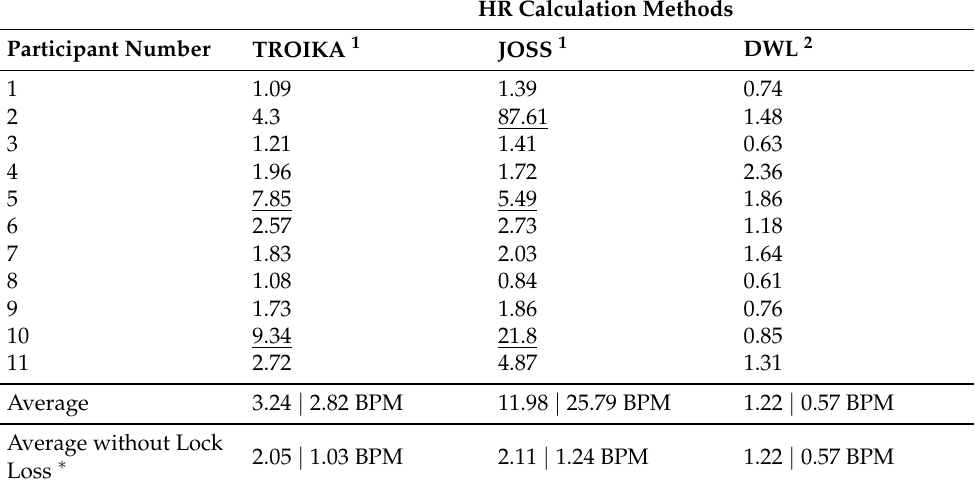
Table 2. MAE in BPM for all eleven (11) experimental participants, using DWL, TROIKA, and JOSS (ideal MAE is 0). The second to last row shows the MAE average of all eleven (11) participants shown as “mean | standard deviation”. The last row shows the MAE average of participants that do not suffer from Lock Loss (MAE value is less than 5 BPM). We underline the MAE values that exceed 5 BPM.